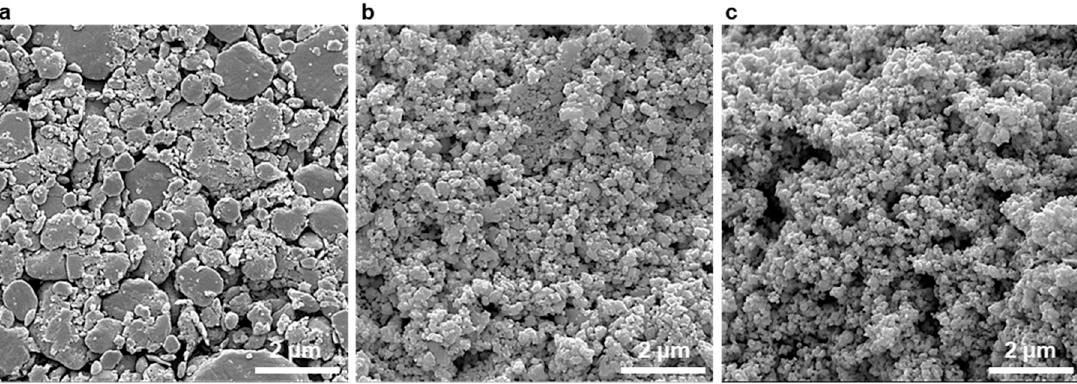
Figure 5. SEM images of ( a ) the as-synthesized BST NPs and post-wet-milled BST NPs for ( b ) 3 and ( c ) 7 days.